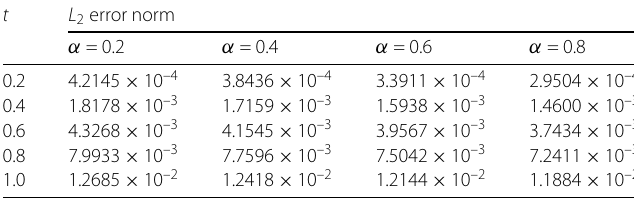
Table 9 Error norms L 2 for Example 2 when α = 0.2, h –3 , (cid:3) t = 0.01, and z ∈